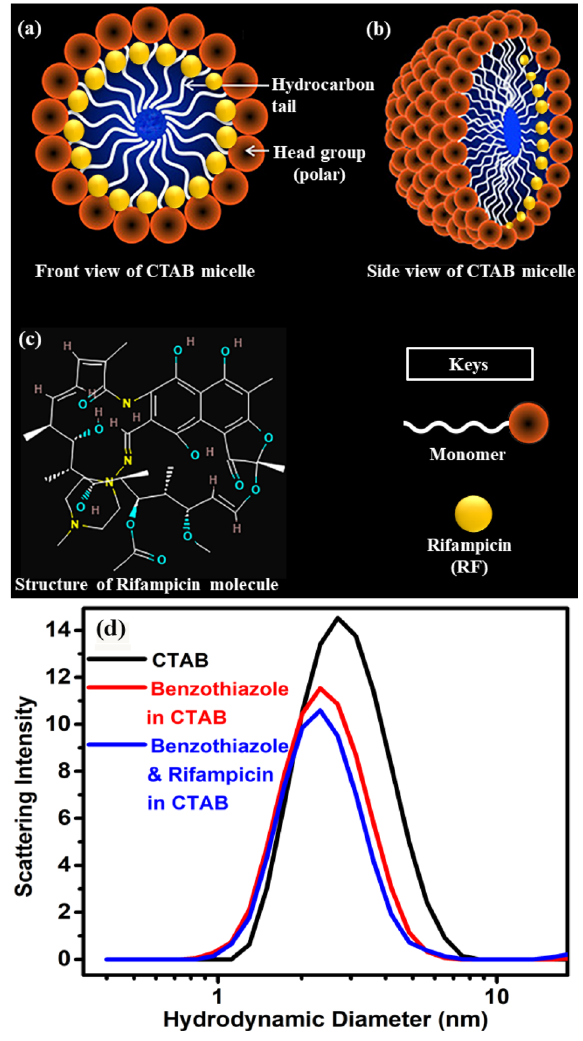
Figure 1. ( a ) Front view of CTAB micelle. ( b ) Side view of CTAB micelle. ( c ) Structure of rifampicin molecule. ( d ) Scattering Intensity of 50 mM CTAB micelle, BT added to CTAB and BT and RF added together to CTAB as obtained from the dynamic light scattering